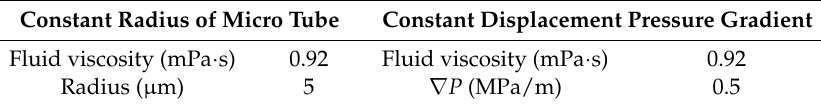
Table 2. Parameters used to study fluid-solid interaction on average flow velocity.